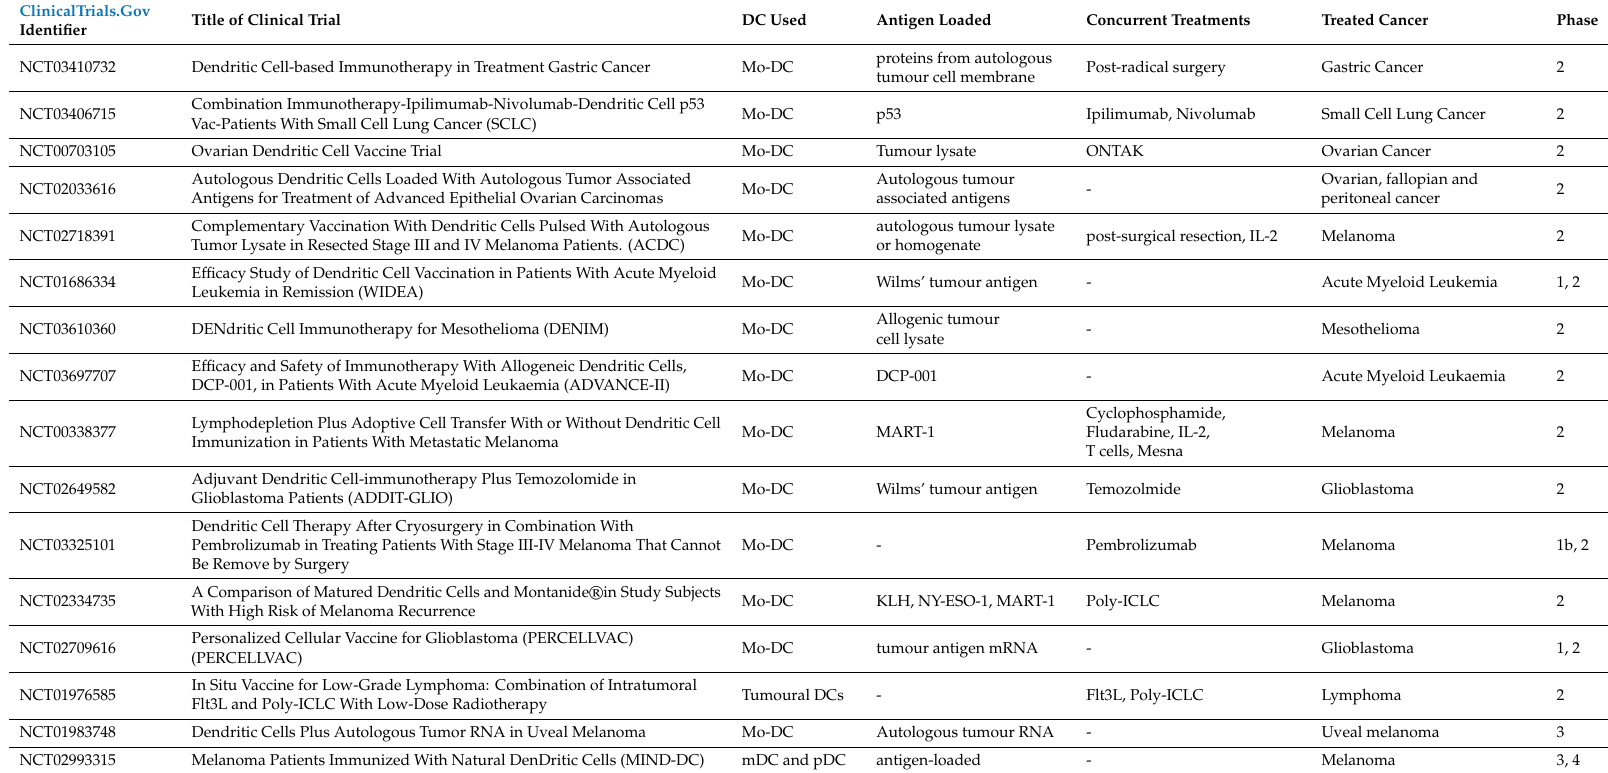
Table 1. List of current DC trials phase II involving